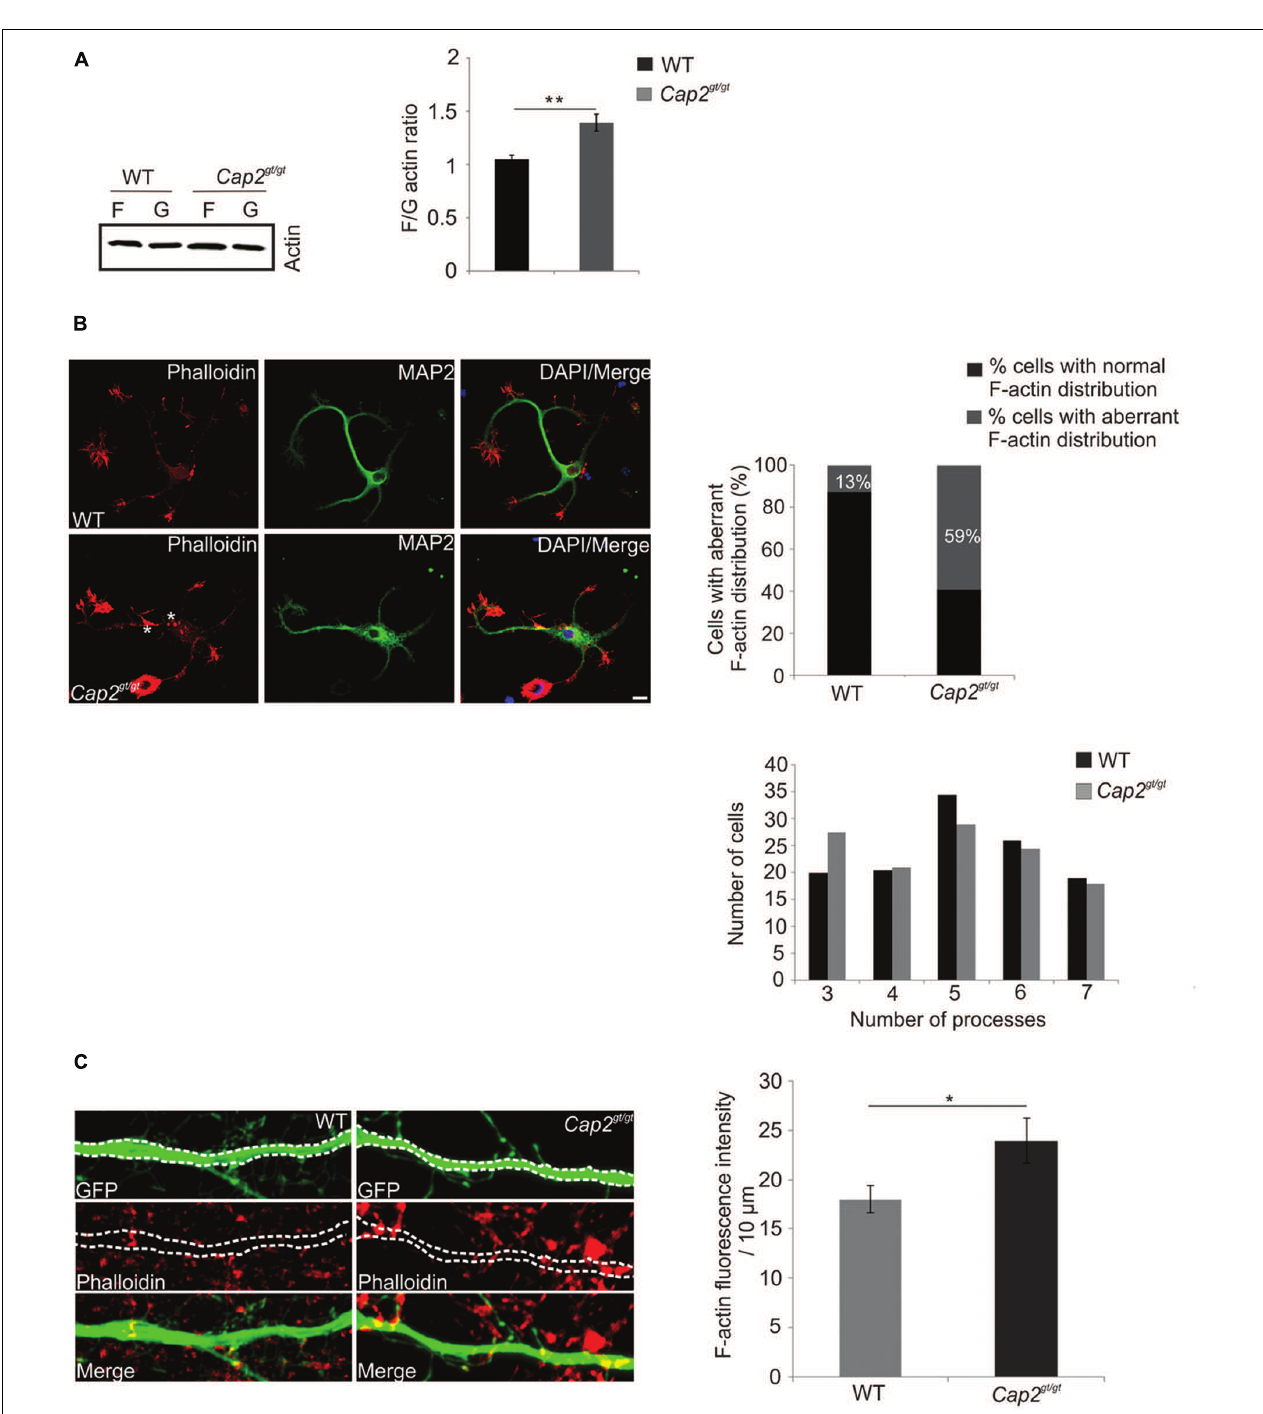
FIGURE 6 | CAP2 deletion leads to actin accumulation and impaired actin dynamics. (A) Immunoblotting of WT and CAP2 mutant brain lysate for determination of the F/G-actin ratio revealed an increase in F-actin in mutant brain lysate (WT: 1.06 ± 0.03, n = 4 mice; Cap2 gt / gt : 1.3 ± 0.1, n = 4 mice, p < 0.01). (B) Immunocytochemistry of cultured cortical neurons after 24 h in cultures demonstrated F-actin accumulation in the soma and in neuritic processes of mutant neurons (white asteriks). F-actin was visualized with phalloidin staining. Scale bar, 10 µ m. Quantification of WT and mutant neurons showing aberrant F-actin distribution in the soma and/or neuritic processes. Quantification of dendritic processes. The distribution of cells with a certain number of processes is shown. (C) pEGFP-C2 transfected neurons labeled with TRITC-phallodin at div 16. Quantification revealed a significant increase in F-actin intensity in the dendritic shaft (white dashed line; WT: 18.0 ± 1.3 F-actin intensity (AU)/10 µ m; Cap2 gt / gt : 24.0 ± 2.3 F-actin intensity (AU)/10 µ m, n = 20 neurons from 3 experiments, p < 0.05). Scale bar, 5 µ m. AU, arbitrary unit; ∗ p < 0.05, ∗∗ p < 0.01.